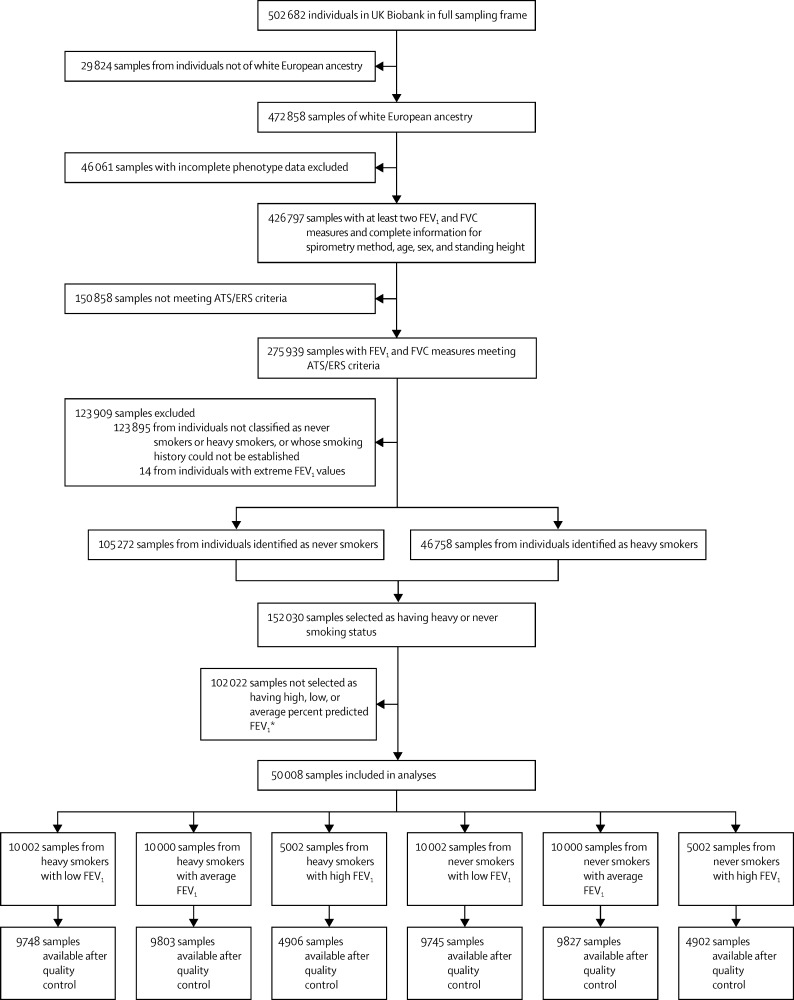
Sample selection strategyATS=American Thoracic Society. ERS=European Respiratory Society.34 FEV1=forced expiratory volume in 1 s. FVC= forced vital capacity. *See appendix (pp 3–5) for more details of sample selection.